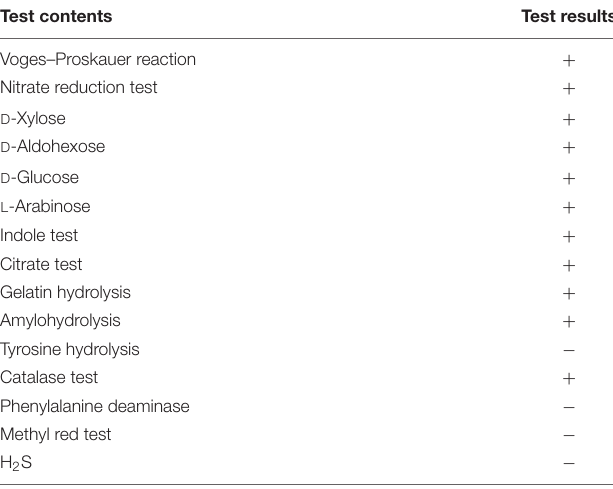
TABLE 1 | The physiological and biochemical tests of